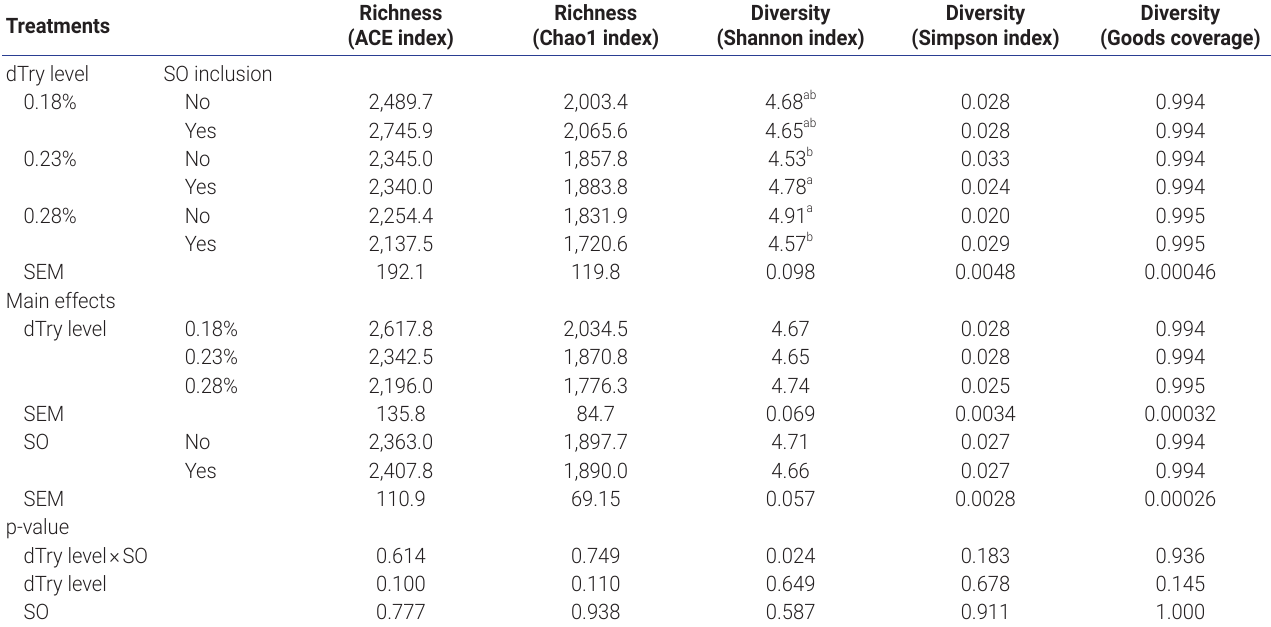
Table 6. Effects of dietary digestible tryptophan (dTry) and soy oligossacharide (SO) supplementation on microflora richness and diversity index in caecal contents of broiler chickens